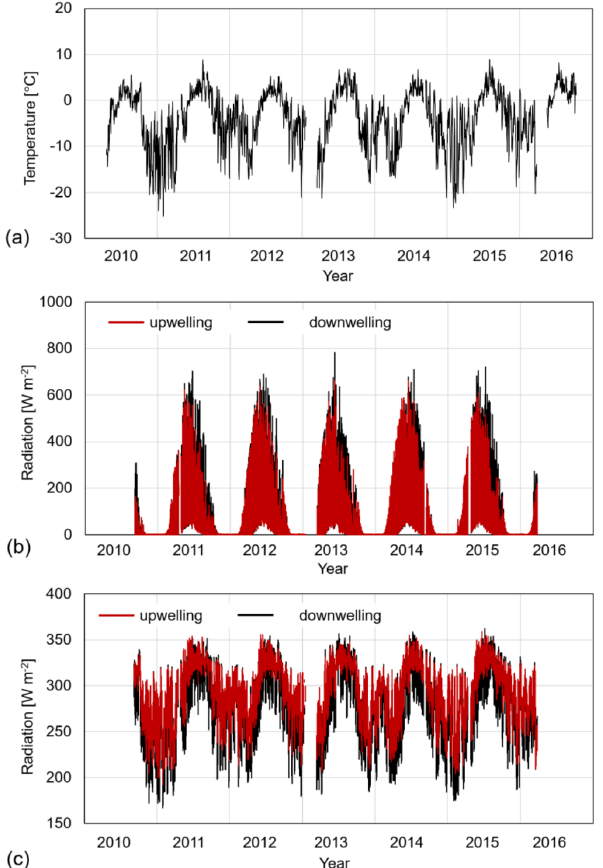
Figure 2. Time series of meteorological variables from 2010 to 2016 on Werenskioldbreen, including daily average air tempera- ture (a) , hourly average short-wave radiation (b) and hourly average long-wave radiation (c) for downwelling (black line) and upwelling (red line) radiation.